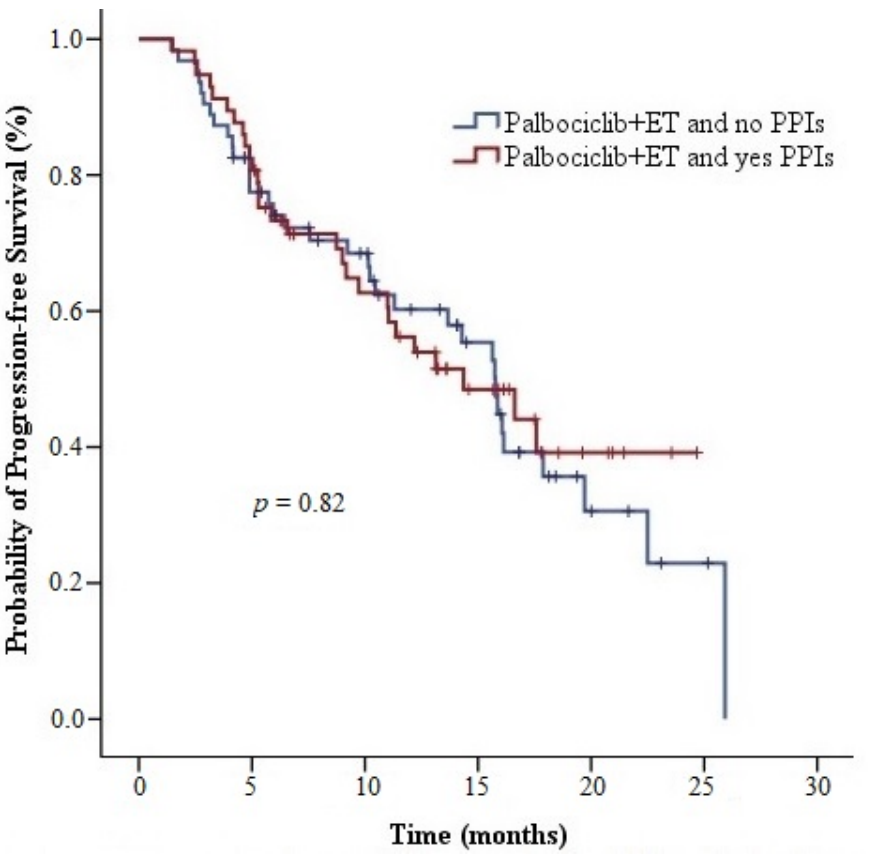
Figure 2. Progression-free survival curves of palbociclib + endocrine therapy with or without proton pump inhibitor. Abbreviations: ER, estrogen receptor; PPI, proton pump inhibitor.